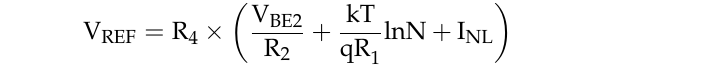
Figure 7. In reference 1 ( a ) 200 Monte Carlo simulation results for TC after first-order temperature compensation; ( b ) 200 Monte Carlo simulation results for TC after high-order temperature compensation.